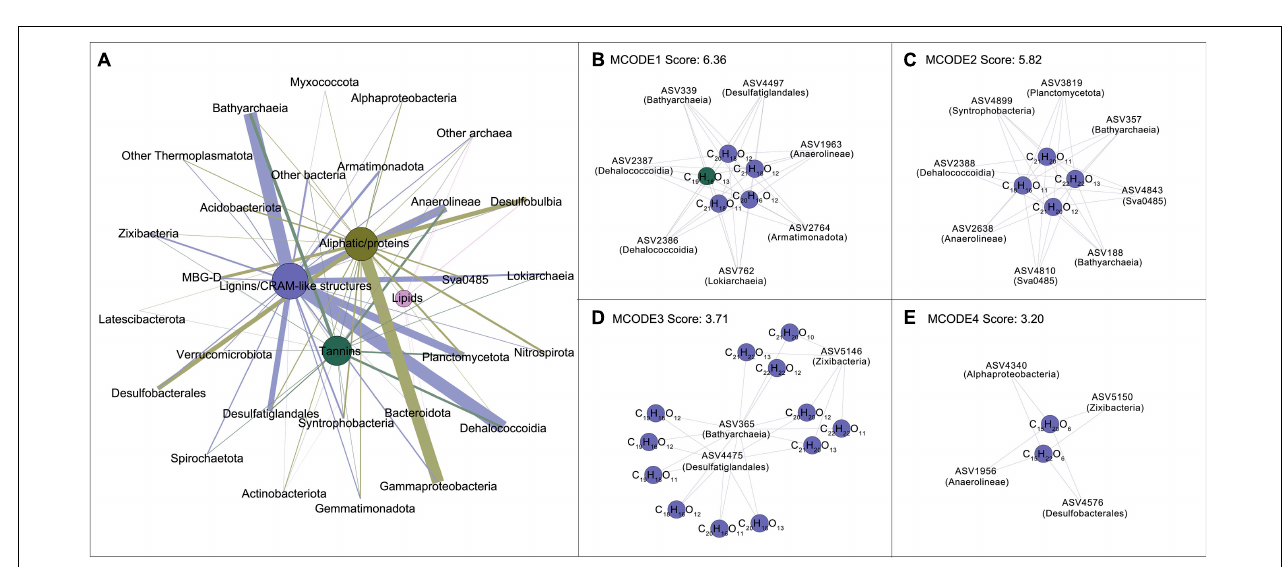
FIGURE 5 | Co-occurrence patterns of microbial and DOM compositions. (A) Network generated by grouping with categories of original network displayed in Supplementary Figure 3 for better visualization. The nodes represent the clusters of microbial amplicon sequence variants (ASVs) or DOM molecules belonging to the same category. Node and edge sizes are proportional to the number of significant connections (Pearson’s correlation with r ≥ 0.65, P < 0.01) (degree). (B–E) Four sub-networks with highest node scores identified by MCODE analysis with default parameters; the nodes represent microbial ASVs or DOM molecules. The color of nodes indicates distinct microbial groups or DOM compounds; the color of edges indicates distinct targets to DOM compounds.